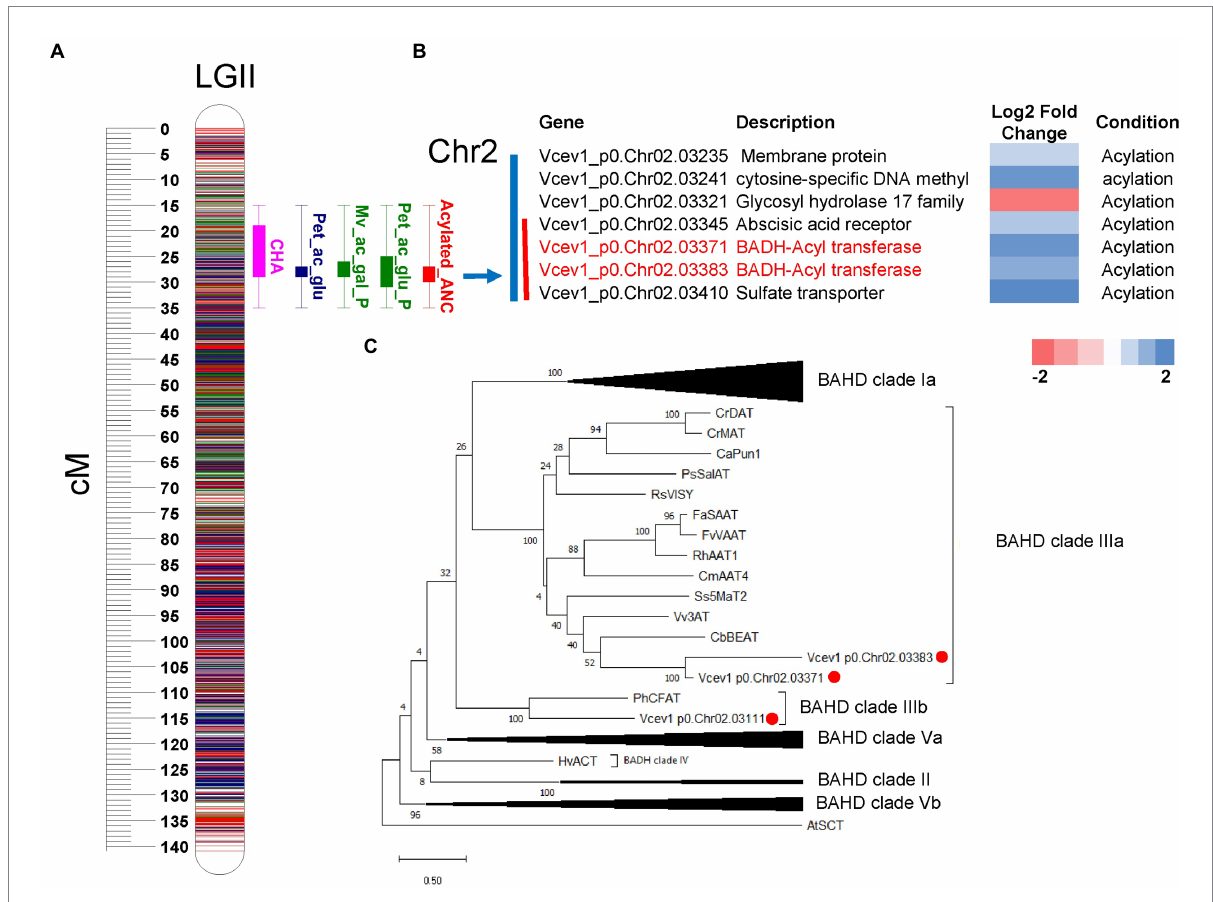
FIGURE 7 QTL mapping and DEGs from RNA-seq analysis. (A) Representation of the acylation related QTLs cluster mapped on chromosome 2. Boxplot represents the QTL position for acylated anthocyanins (blue and green), CHA (rose) and relative contribution (%) of acylated anthocyanin to the totalANC (red). The boxplot represents the 95% permutation support interval (the interval where the QTL peak exceeds the LOD threshold established using 1,000 permutations and α = 0.05). The solid box of the boxplot represents two-LOD support intervals. (B) List of DEGs located within the genomic region spanning the 95% permutation support interval (blue bar) and two-LOD support intervals (red bar). Genes that are directly related to acylation are highlighted in red. Log2foldchange represents the gene expression levels from down-regulated (red) to up-regulated (blue). Condition represents the following pairwise comparison performed during gene expression analysis: Acylation = high-acylated vs. low-acylated samples. For each trait, the two-LOD and 95% support interval presented here represent the overlap of the QTL regions detected across 3 years. (C) Maximum Likelihood phylogenetic tree of selected plant BADH and putative blueberry BADHs identified as DEG within the region spanning the 95% QTL support interval. Bootstrap values are percentage from 100 replicates. The Genbank ID for the sequences are reported in Table S2. Red circles indicate blueberry genes clustered with known BADHs